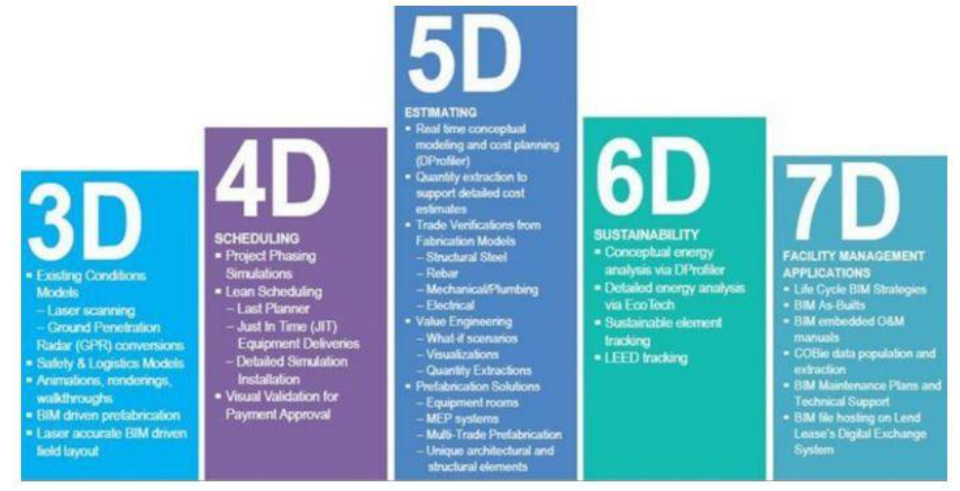
Figure 1: Dimensions of BIM data model,